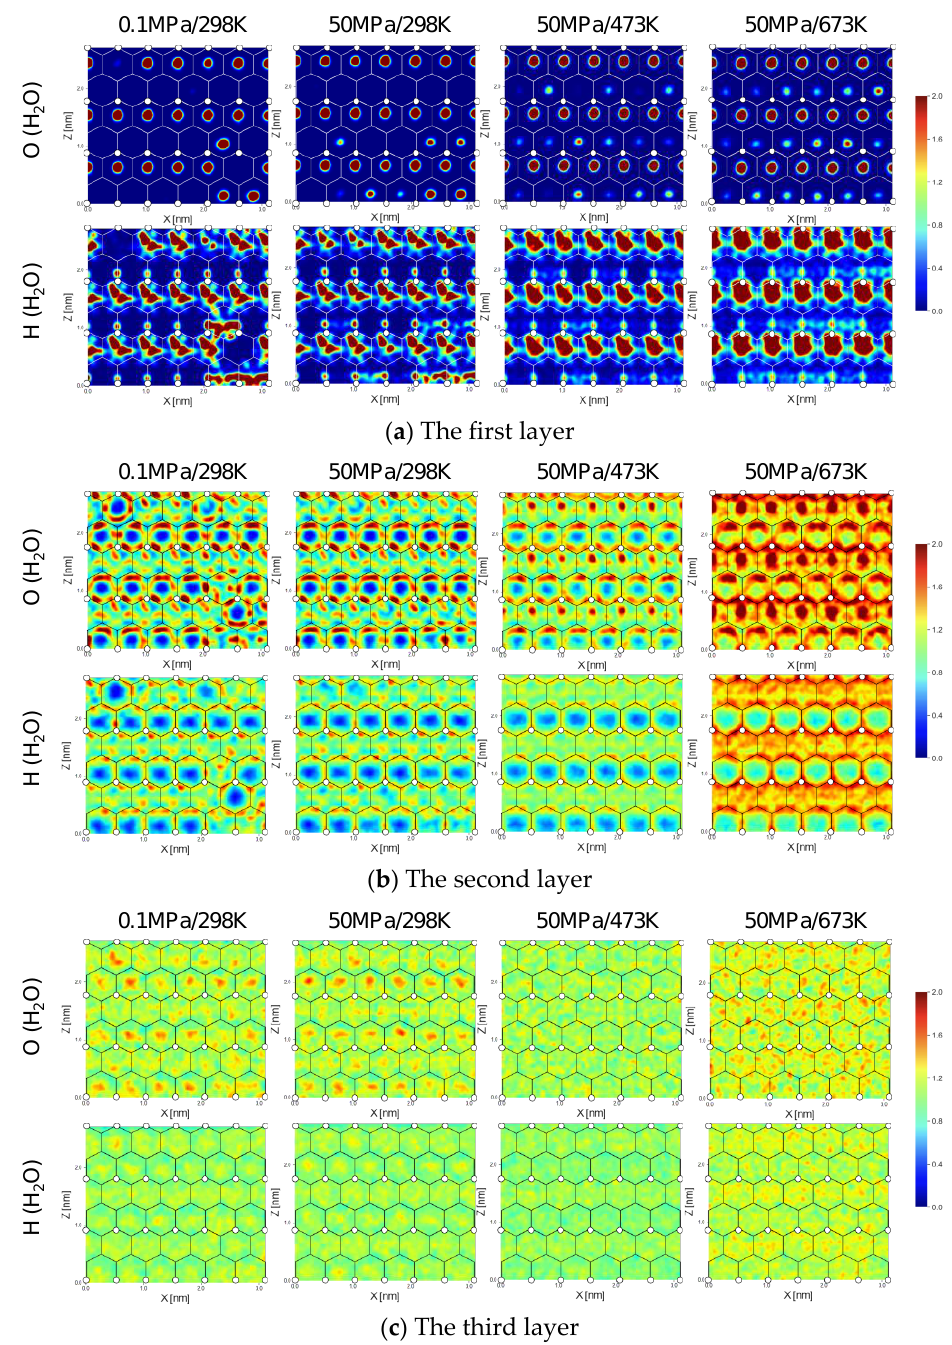
Figure 4. 2D normalized density maps of O and H atoms of H 2 O molecules at ( a ) the first layer, ( b ) the second layer, and ( c ) the third layer; the lattice on the map is from Figure S6 in Supplementary Materials.